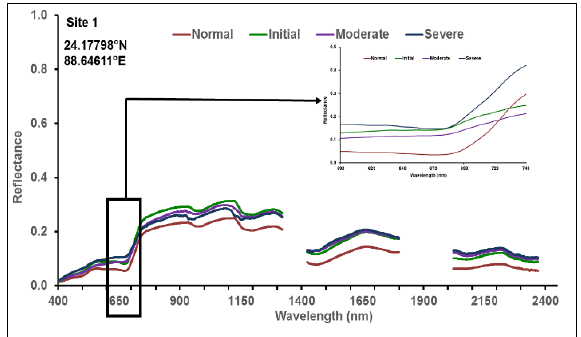
Figure 1. In situ spectral response of healthy and blast infested wheat crop